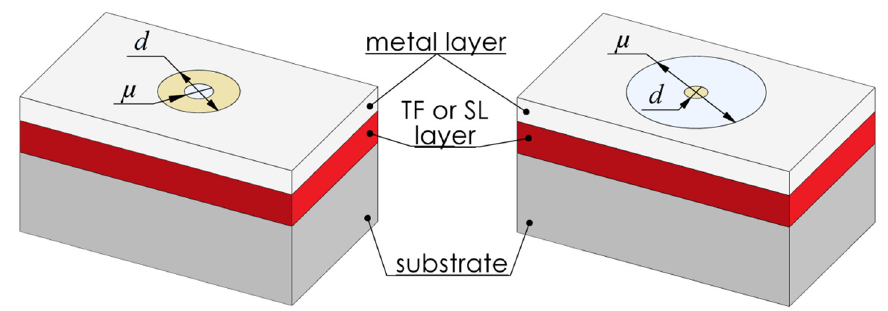
Figure 5. Cross-plane ( left ) and in-plane ( right ) geometry in frequency-domain methods.